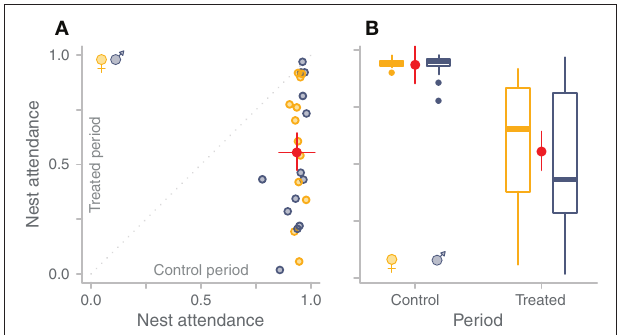
FIGURE 3 | Compensation for the temporary absence of the partner. (A,B) The control period reflects the regular incubation bout of the focal parent, while the treated period is the period during which the focal parent’s partner should have incubated, but was held in captivity. Yellow indicates female, blue-gray male. Red dots with bars indicate model predictions with 95%CI (Table S1 in Bulla, 2019). (A) Compensation by each individual ( N = 25). The gray dashed line indicates full compensation. Each dot represents nest attendance of one individual; points below the line represent various degrees of partial compensation or no compensation (zero). (B) Nest attendance in the control and treated period for females ( N = 12) and males ( N = 13) separately. Box plots depict median (horizontal line inside the box), the 25th and 75th percentiles (box), the 25th and 75th percentiles ± 1.5 times the interquartile range or the minimum/maximum value, whichever is smaller (bars), and the outliers